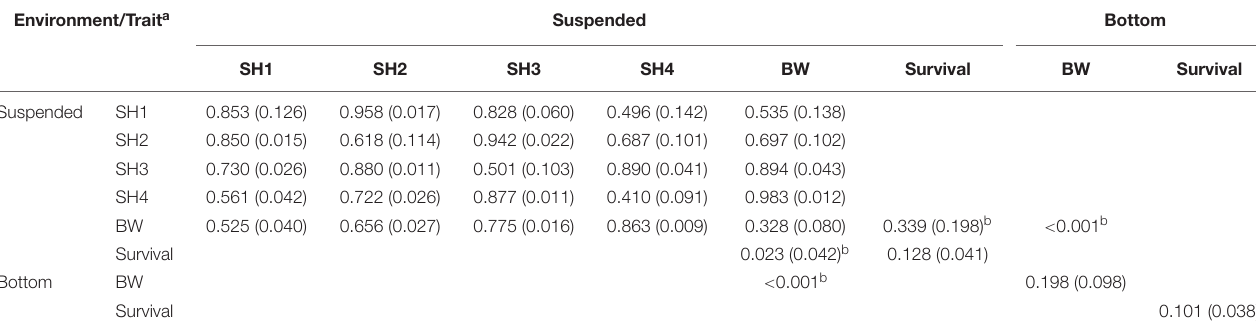
TABLE 2 | Estimates of heritabilities (the diagonal), genetic correlation (above the diagonal), and phenotypic correlation (below the diagonal) between varying traits in yesso scallop at two environments. Environment/Trait a Suspended Bottom